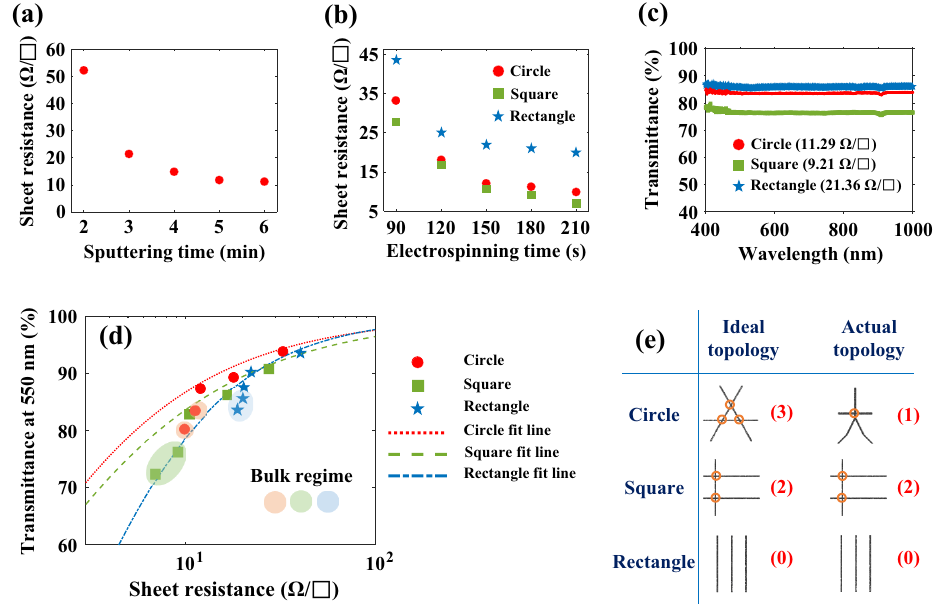
Figure 3. Sheet resistances ( R s ) and transmittances ( T ) of the CS NF networks obtained using the circular, square, and rectangular electrode collectors. ( a ) R s of the CS NF network obtained using the circular electrode collector with respect to sputtering time, ( b ) R s values of the CS NF networks with respect to electrospinning time, ( c ) T values of the CS NF networks (180 s electrospinning time) with respect to wavelength, and ( d ) T values (at 550 nm) of the CS NF networks with respect to R s . ( e ) Number of nodes depending on the ideal and actual